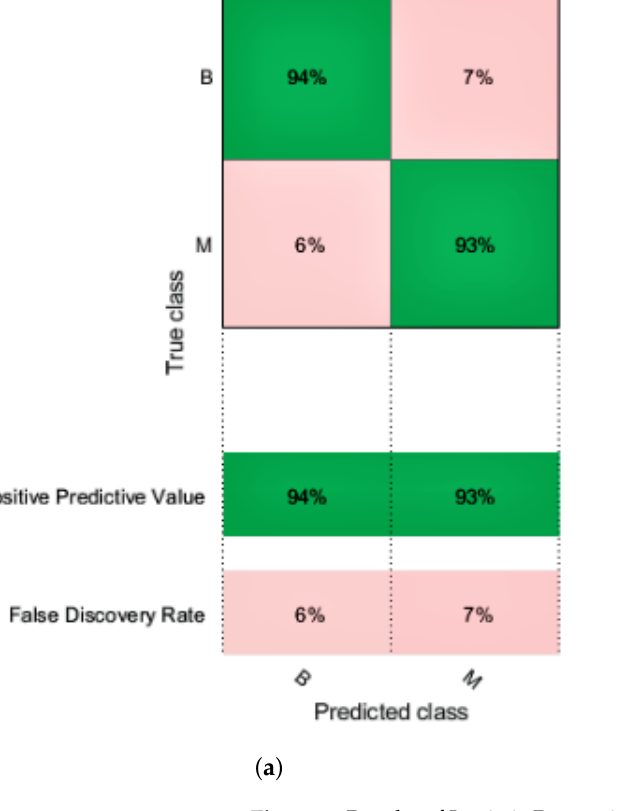
Figure 4. Results of Logistic Regression. ( a ) Confusion matrix; ( b ) AUC of LR. After overall simulation, we obtain a confusion matrix; the receiver operating char- acteristic (ROC), parallel coordination, and scattered plot of SVM models are given in Figures 5a,b and 6a,b, respectively. Finally, we obtain the following accuracy percentage of different SVM models given in Table 7. Table 7. Accuracy of SVM